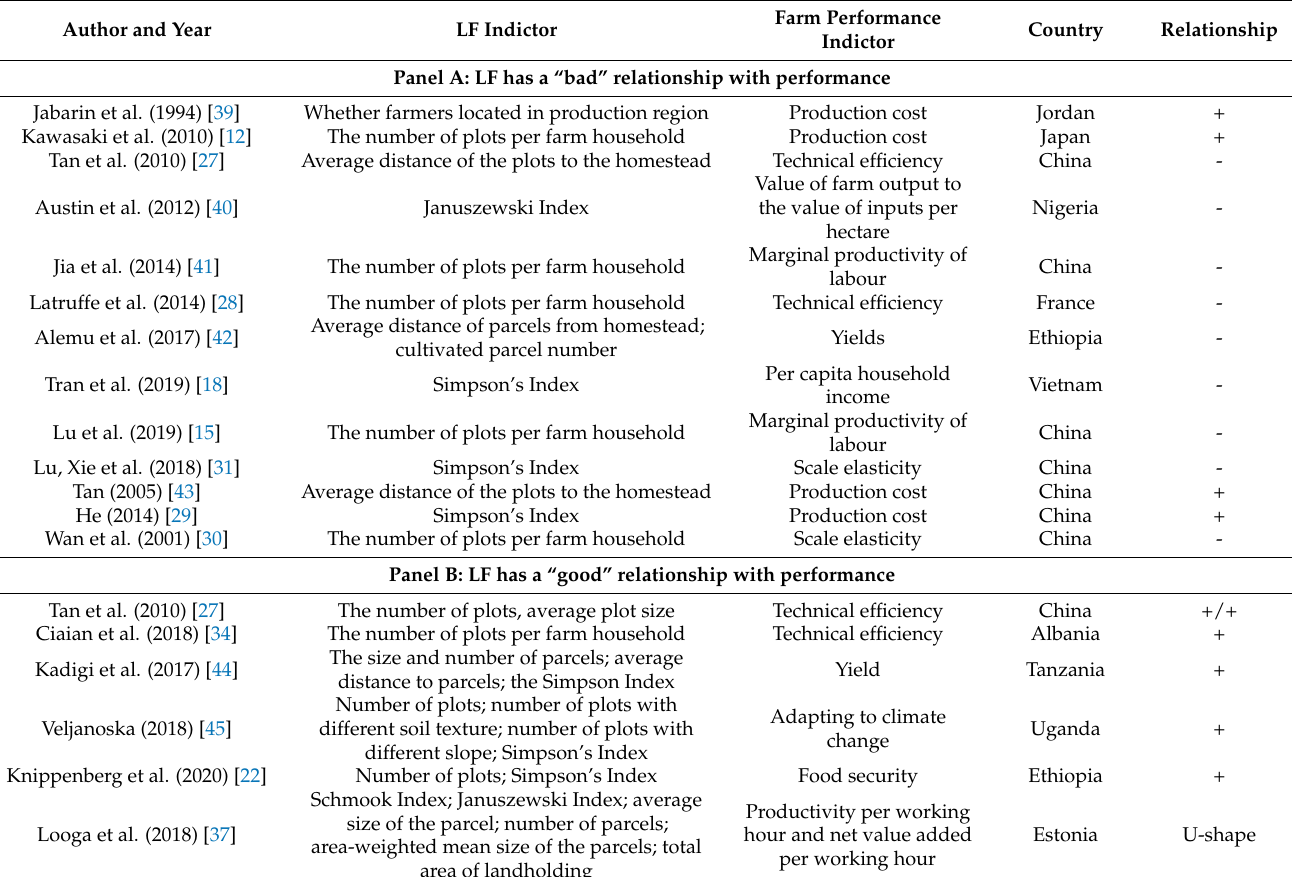
Table 1. Literature review on LF, farm performance, and their